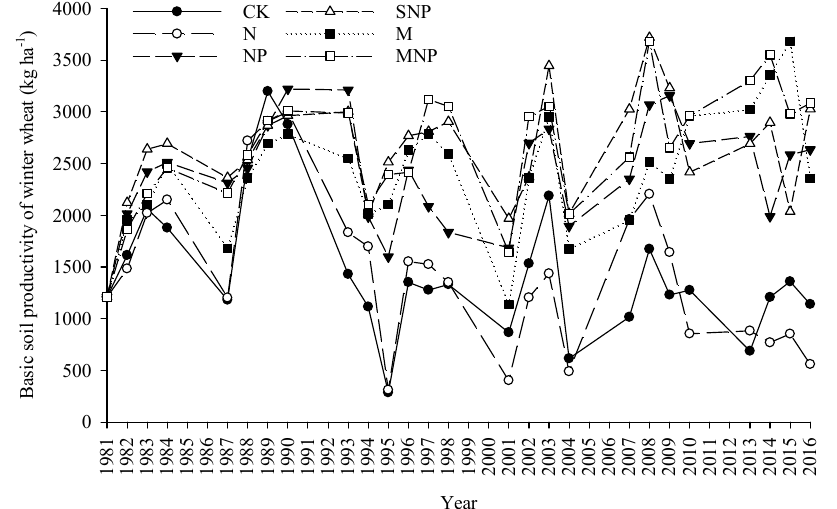
Figure 2. The trend of basic soil productivity of winter wheat under different fertilizations from 1981–2016.